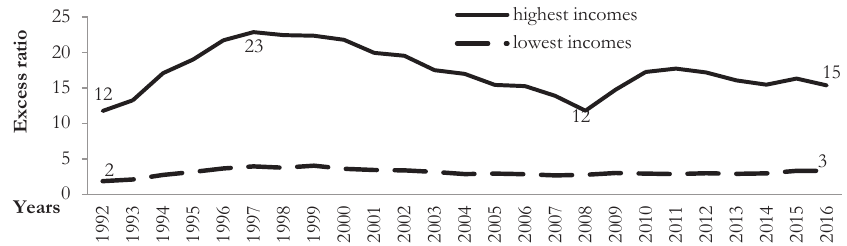
Fig. 5 – The excess ratio of GDP (PPP) per capita of developed economies over Ukraine. Source: own calculation based on IMF (2018)